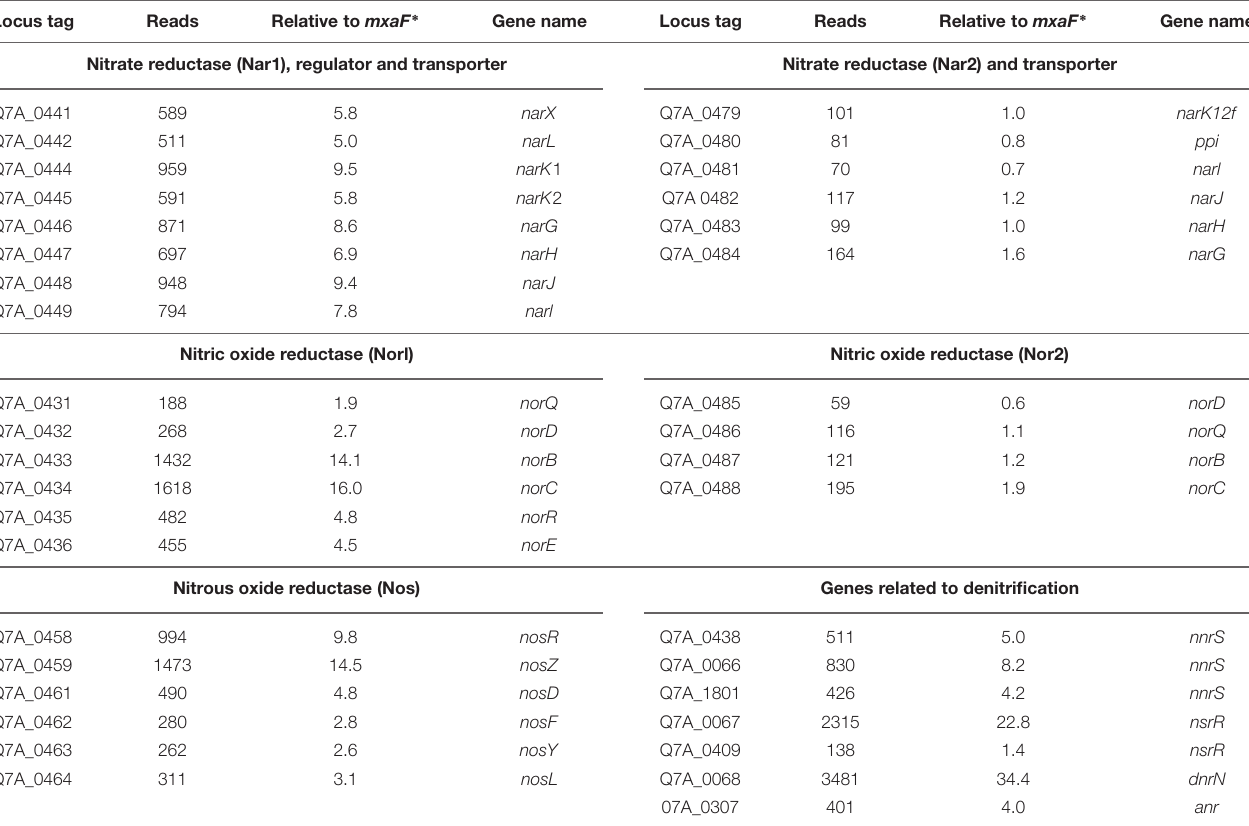
TABLE 2 | Relative level of transcriptomic reads of the denitrification genes. Locus tag